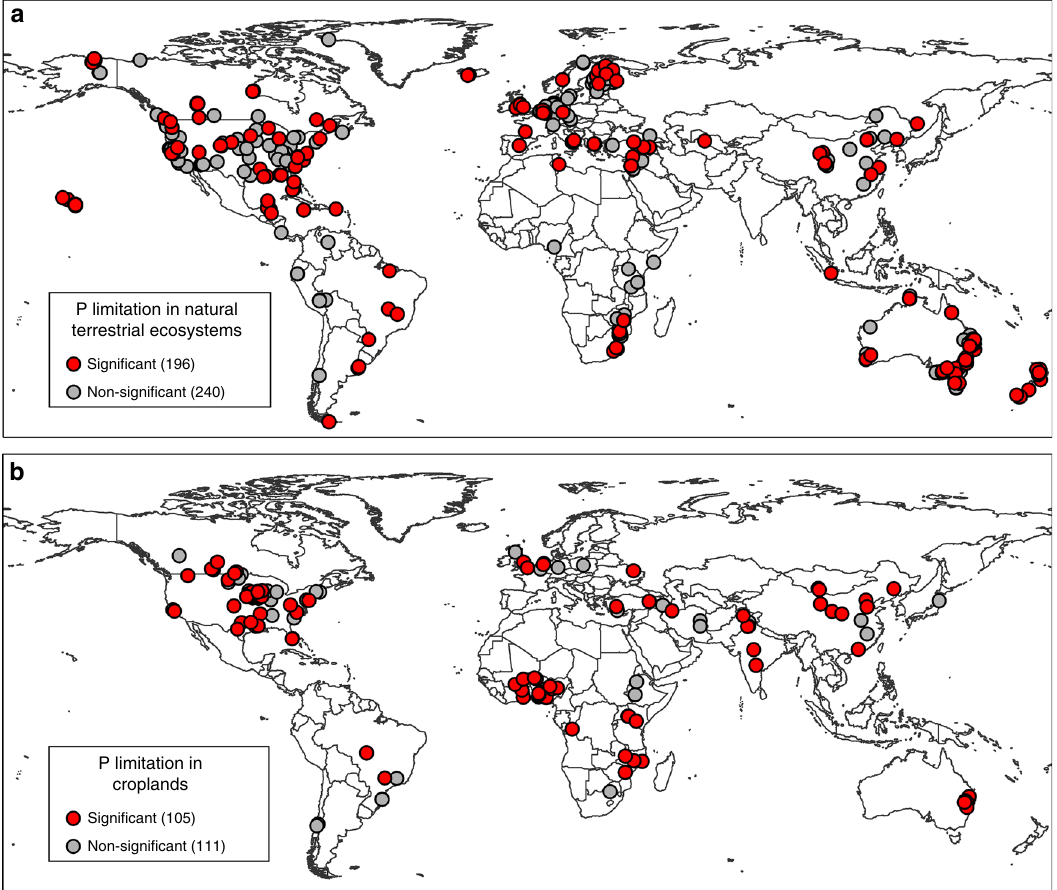
Fig. 1 Locations of the 652 experiments in which the effect of P addition on aboveground plant production was assessed. a Natural terrestrial ecosystems. b Croplands. Experiments were determined to have signi fi cant P limitation based on the Ln(Response Ratio). If the Ln(Response Ratio) was higher than a threshold value (0.23 for natural terrestrial ecosystems and 0.09 for croplands), it was considered a signi fi cant case ( Z test, P < 0.05) of P limitation. Determination of the threshold values is described in the “ Methods ” section and is supported by the Supplementary Fig. 3. Numbers in brackets are the number of experiments in the indicated group. Source data are provided as a Source Data fi